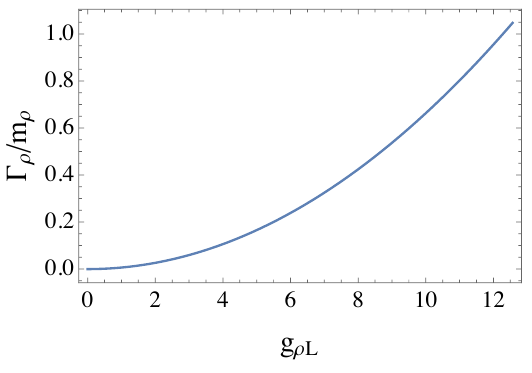
Figure 6 . The ratio (cid:0) (cid:26) =m (cid:26) in eq. (5.15) as a function of g (cid:26)L